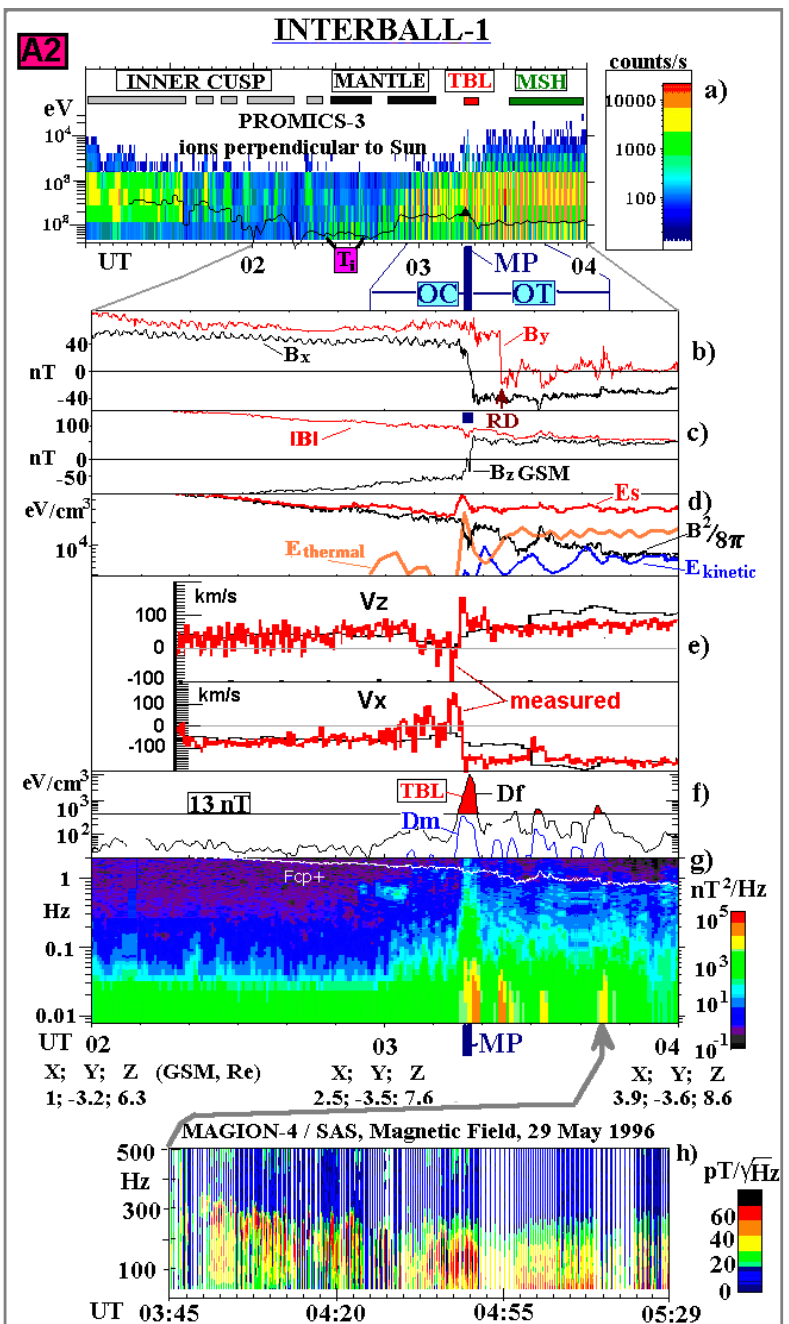
Plate A2. Outbound MSH/cusp interface crossing by Interball-1 and Magion-4 on 29 May 1996. The regions depicted in Plate A1 are marked at the top of panels (a), (b). Panel (a) : energy distribution of the protons perpendicular to the Sun-Earth line (PROMICS-3); the ion temperature T i is depicted by a black line. Panels (b) and (c) : magnetic field in the GSM coordinates. Panel (d) : the total energy density, Es (red), the thermal energy density, E thermal (brown), the kinetic energy density, E kinetic and the magnetic energy density, Em = B 2 / 8 π (black). Panel (e) : GSE V x and V z components of ion velocity from the MHD model of Fedder et al. (1995) (black trace) and measurements by SKA-1 ion spectrometer (red colored). Panel (f) : the power in the magnetic field variations, Df , and the standard deviation of the magnetic field magnitude, Dm (blue). Panel (g) : Fourier spectrogram of the magnetic field power with sampling rate 4Hz; the proton cyclotron frequency labeled “Fcp+” is over-plotted by a white line. Panel (h) : magnetic spectra from Magion-4 in the range 20–2000Hz during a period when Interball-1 observed the upstream